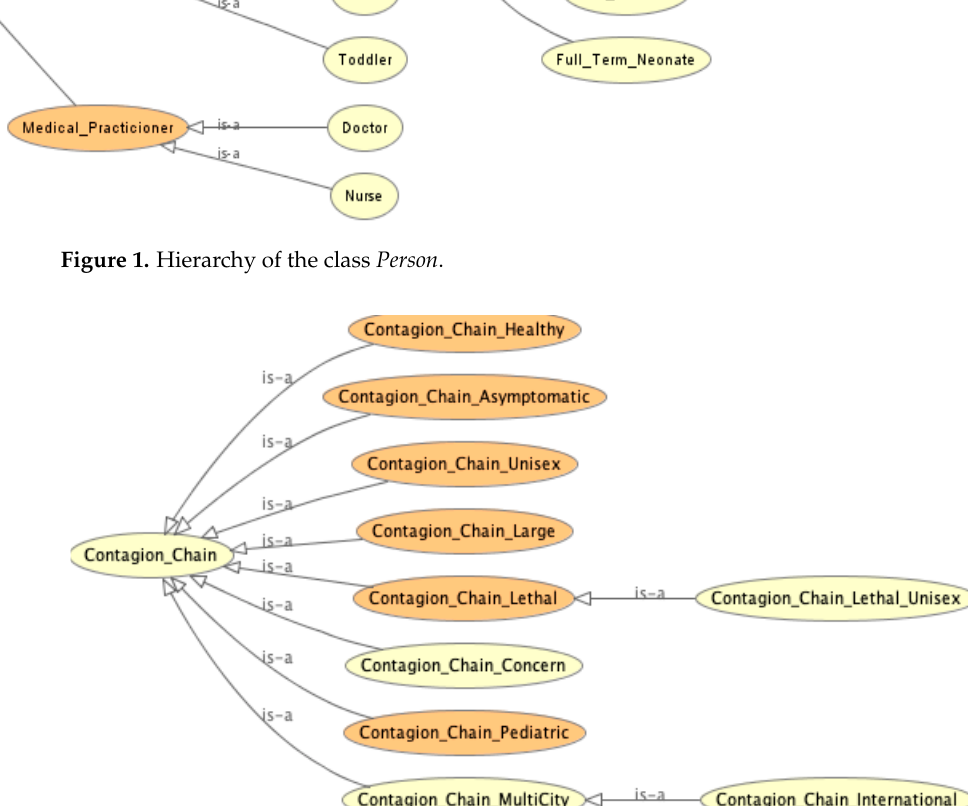
Figure 2. Hierarchy of the class Contagion_Chain. Step 5: Define properties.